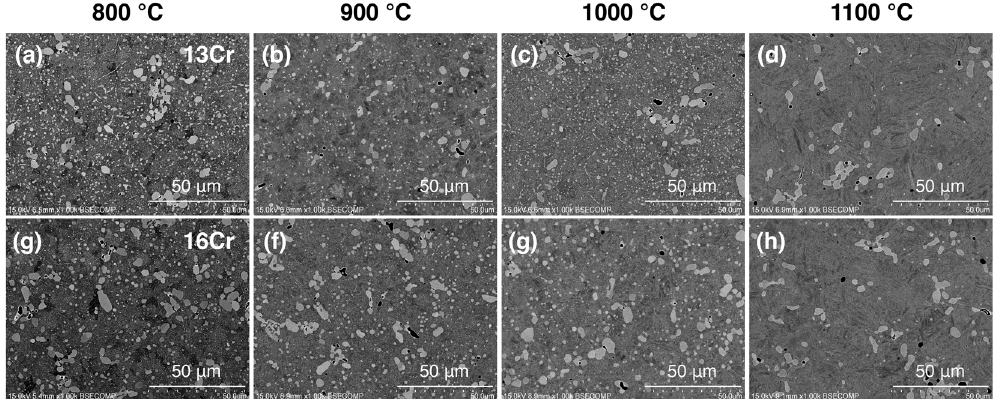
Fig. 1 Microstructures of the developed steels obtained at different heat treatment temperatures. SEM-BSE images for the a – d 13Cr and g – h 16Cr steels heat treated at a , g 800 °C, b , f 900 °C, c , g 1000 °C, and d , h 1100 °C.